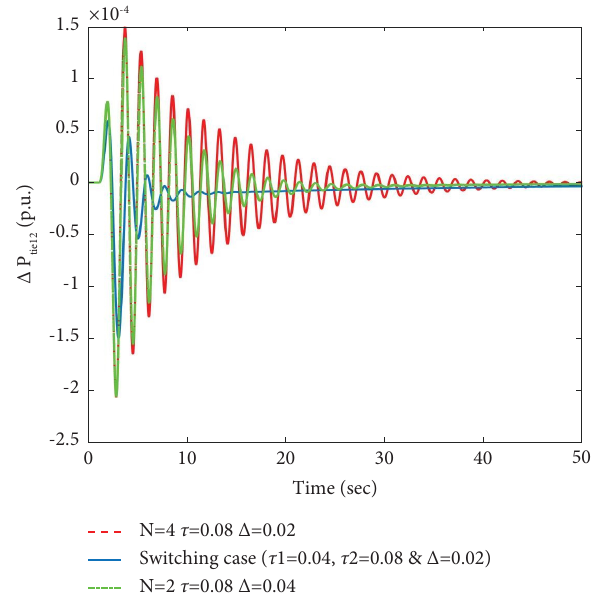
Figure 9: Tie line power deviation Δ P time (sec) with the POF controller having a perfect medium and switching case.